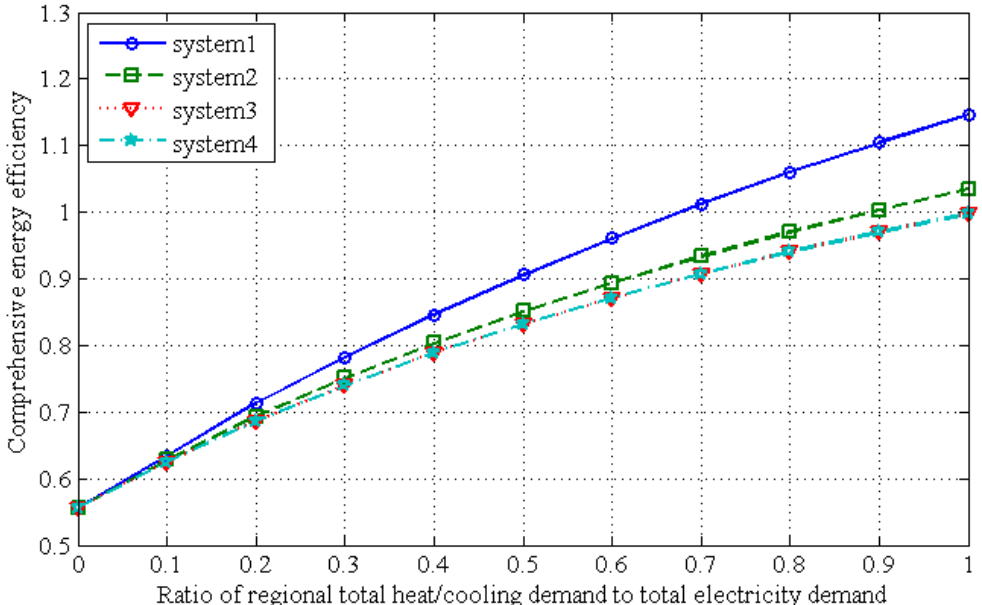
Figure 10. The variation of optimal comprehensive energy efficiency with both y and z .